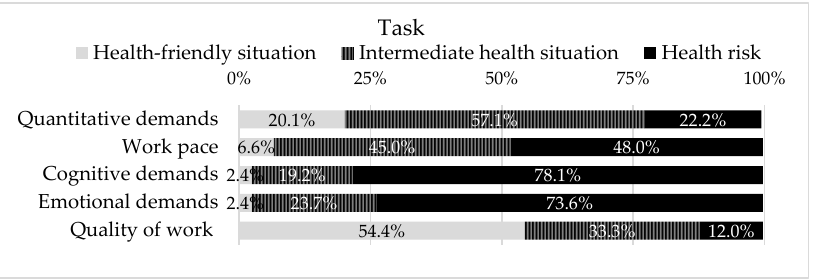
Figure 1. PRFs framed in the element Task of work system (of SEIPS 3.0 model), and the respective health risk that the exposure represents.